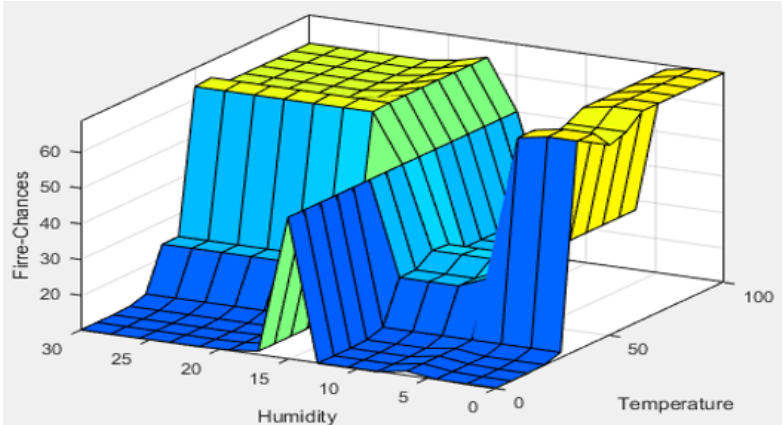
Figure 26. surface viewers for Temperature and Humidity using MATLAB. Figure 26. Surface viewers for Temperature and Humidity using